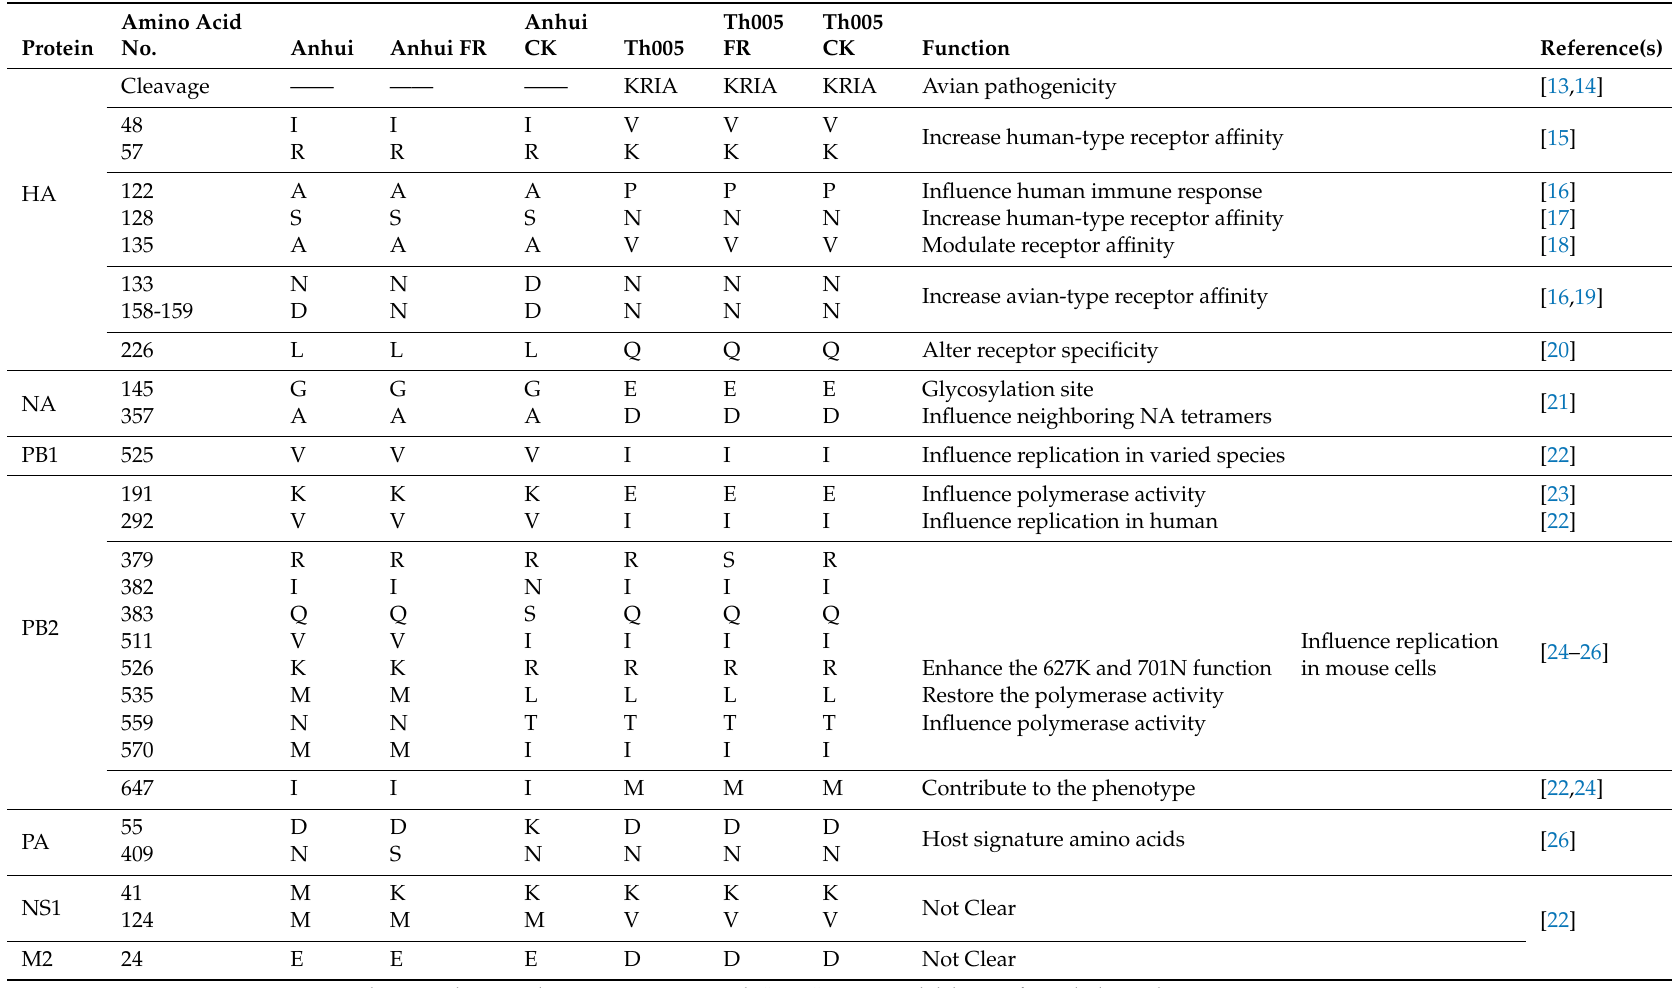
The H3 and N2 numbering system was used. “——”represented deletion of a multi-basic cleavage site in